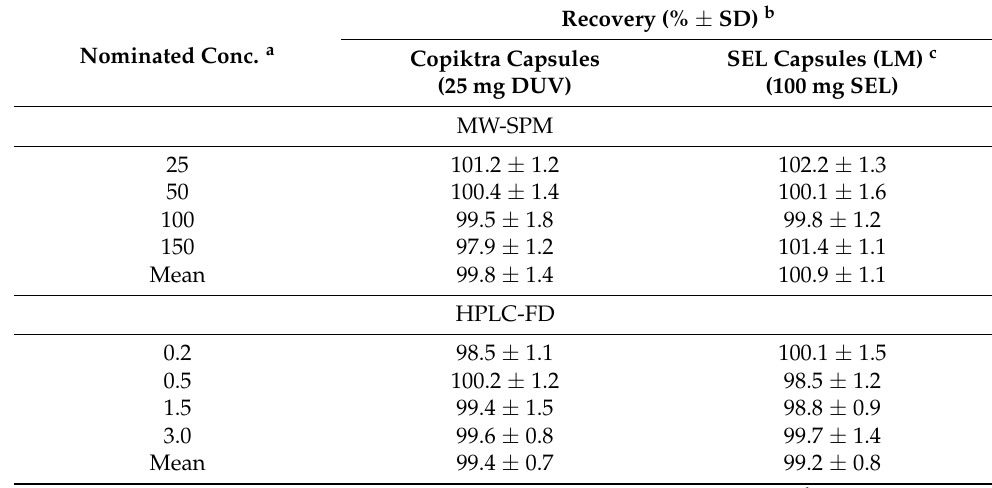
Table 5. Determination of DUV and SEL in their capsules by the proposed MW-SPM and HPLC-FD.